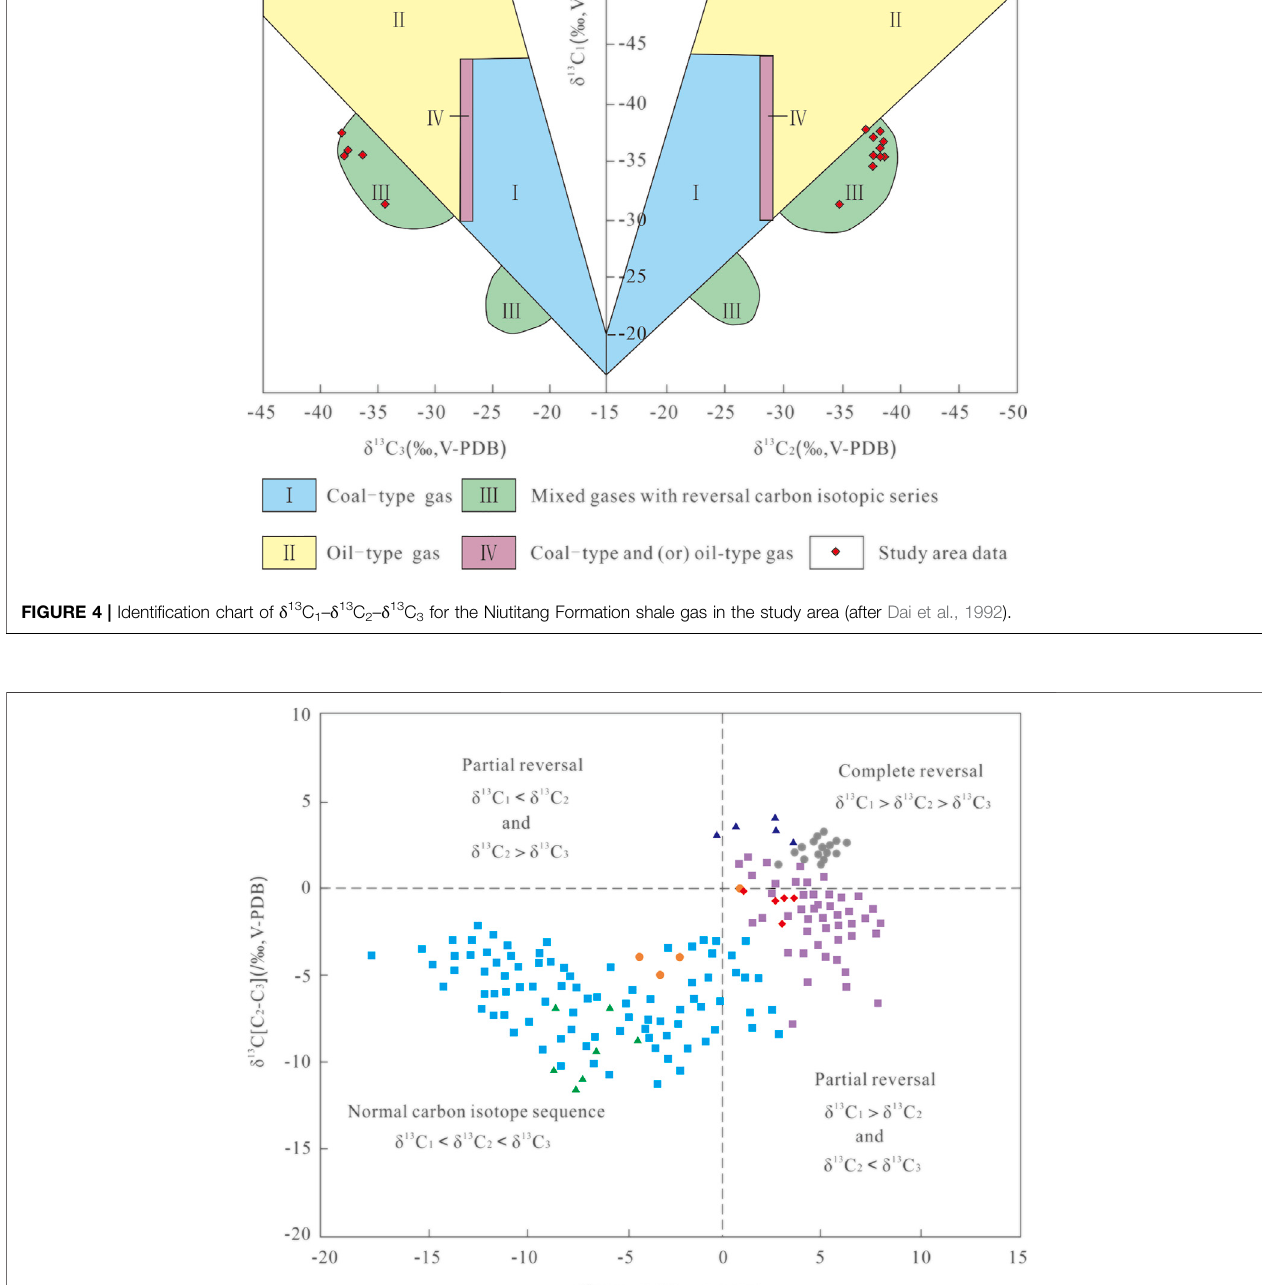
Frontiers in Earth Science |